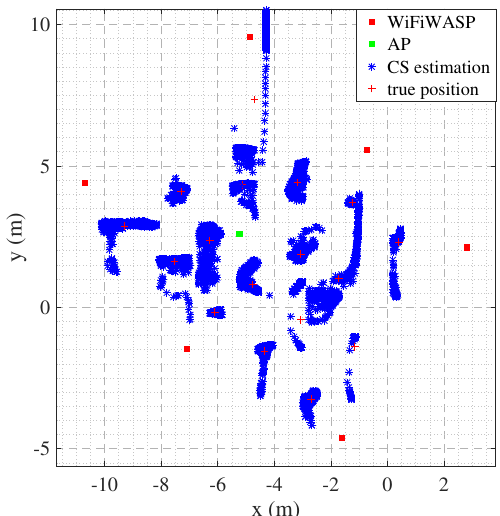
Figure 9. Estimated target locations in the indoor